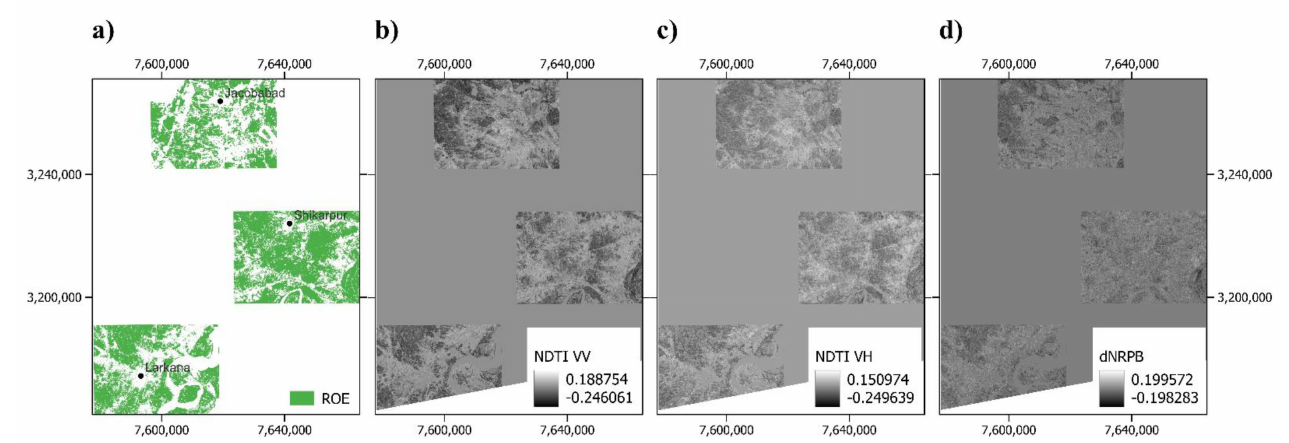
Figure 4. Comparison of SAR-derived index differences (NDTI—Normalized Differenced Temporal Index for both ( b ) vertical-vertical (VV) and ( c ) vertical-horizontal (VH) polarizations; ( d ) dNRPB— difference of Normalized Ratio Procedure between Bands) alongside ( a ) the delineation of the Reference Observed Event (ROE) [41] for the Sindh Province floods (Pakistan) (coordinate reference system: WGS84/World Mercator).